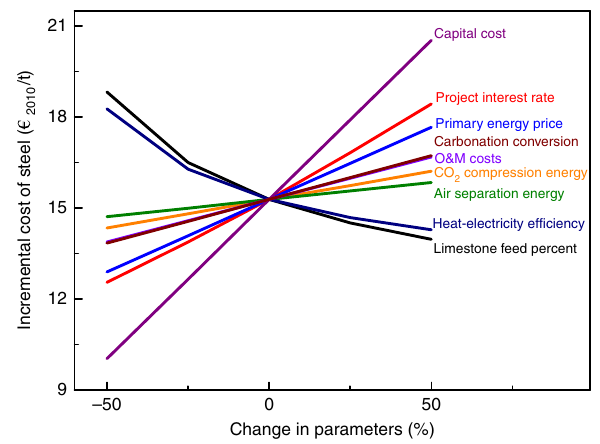
Fig. 7 Sensitivity of the incremental cost of steel due to implementation of the CaL-LP scheme. The in fl uence of nine potentially key parameters on the incremental cost of steel was investigated by changing the value of each parameter up to ± 50%, while holding all other parameters at their base